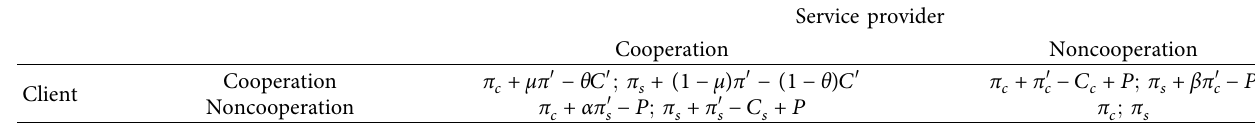
Table 1: Payoff matrix. Service provider Cooperation